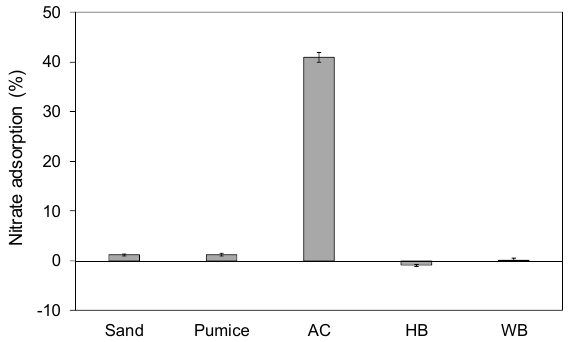
Figure 3. Adsorption from aqueous nitrate affected by geomedia and carbon materials. Error bars represent standard error of the mean.